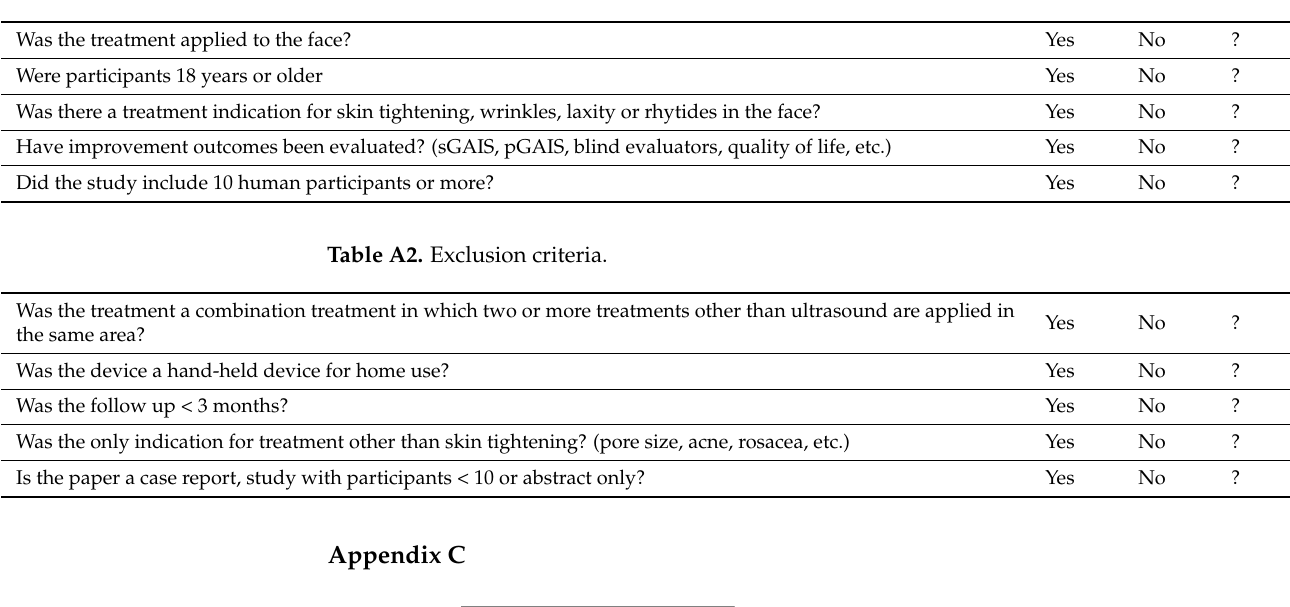
Table A1. Inclusion criteria.